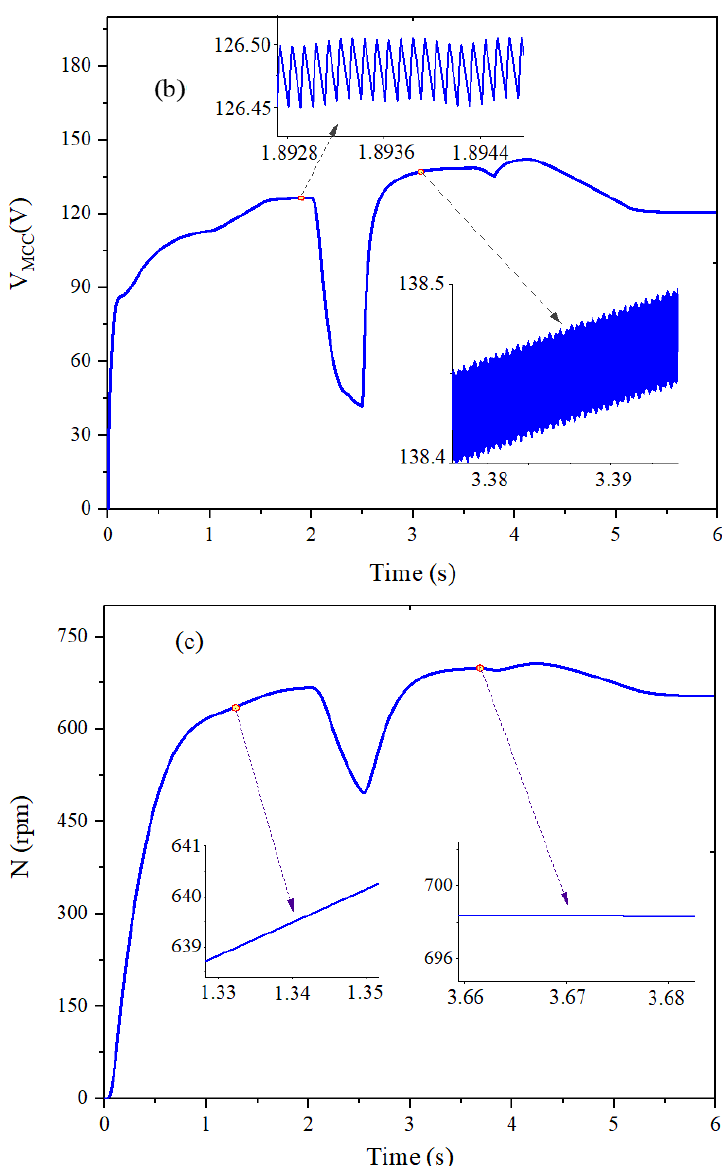
Figure 13. Simulation results associated with the P&O technique. ( a ) Instantaneous power extracted from the GPV, ( b ) terminal voltage at the pump motor, ( c ) rotation speed of the pump motor.